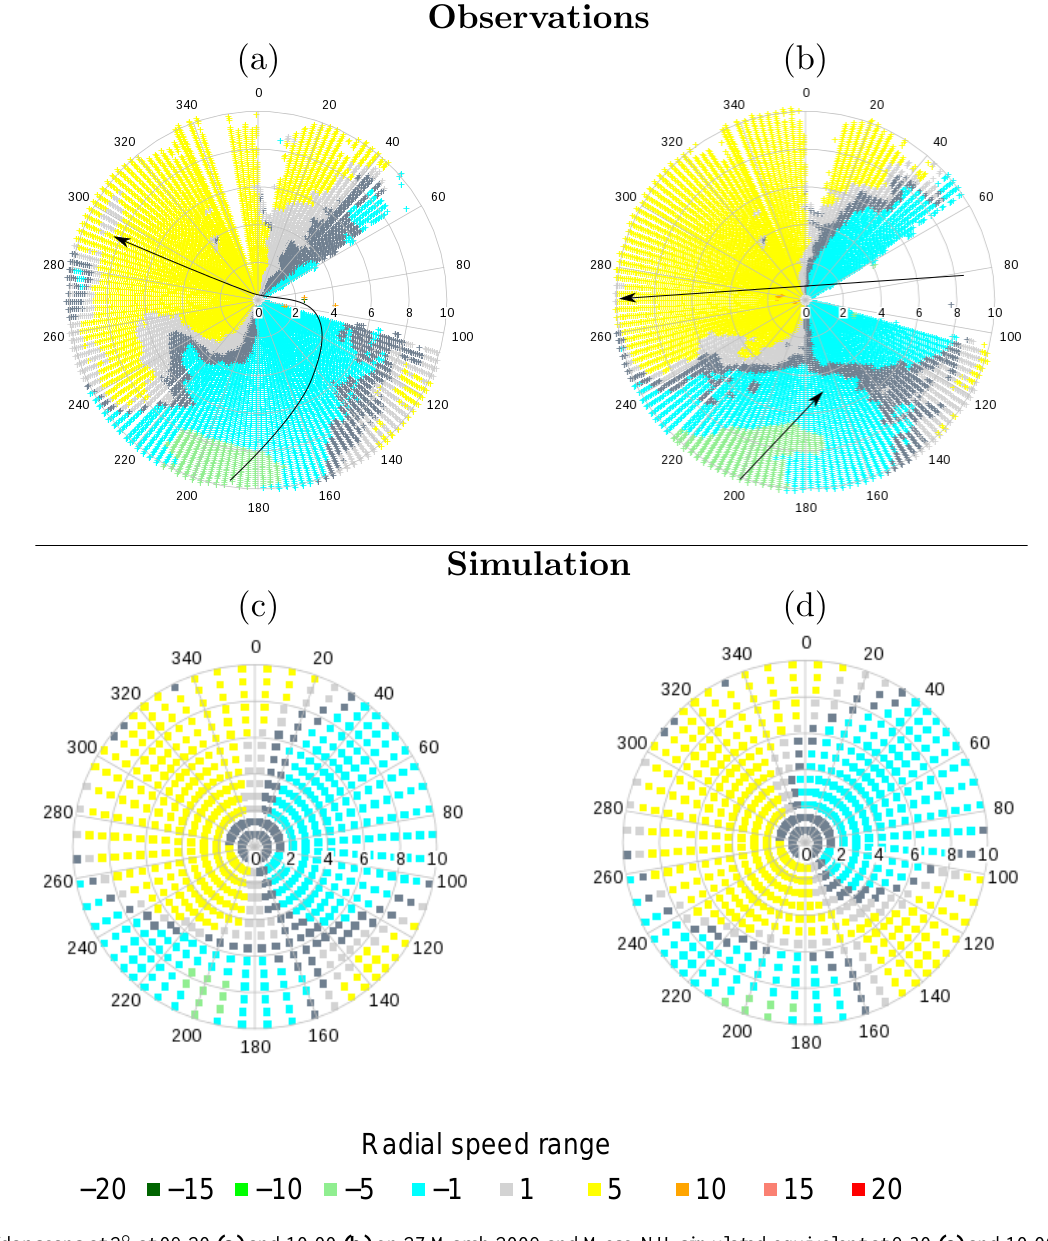
Fig. 16. Lidar scans at 2 ◦ at 09:20 (a) and 10:00 (b) on 27 March 2009 and Meso-NH simulated equivalent at 9:30 (c) and 10:00 (d) .